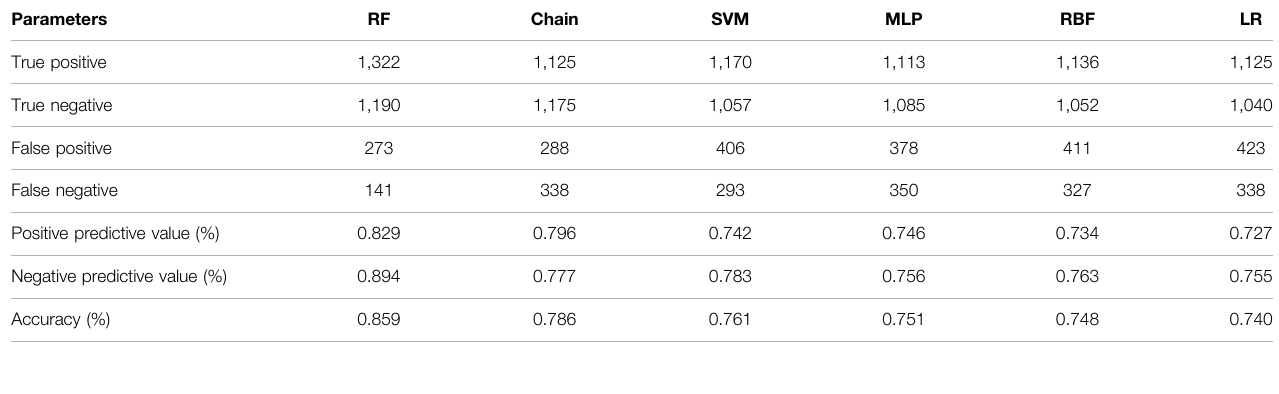
TABLE 3 | ACC performance of all models.